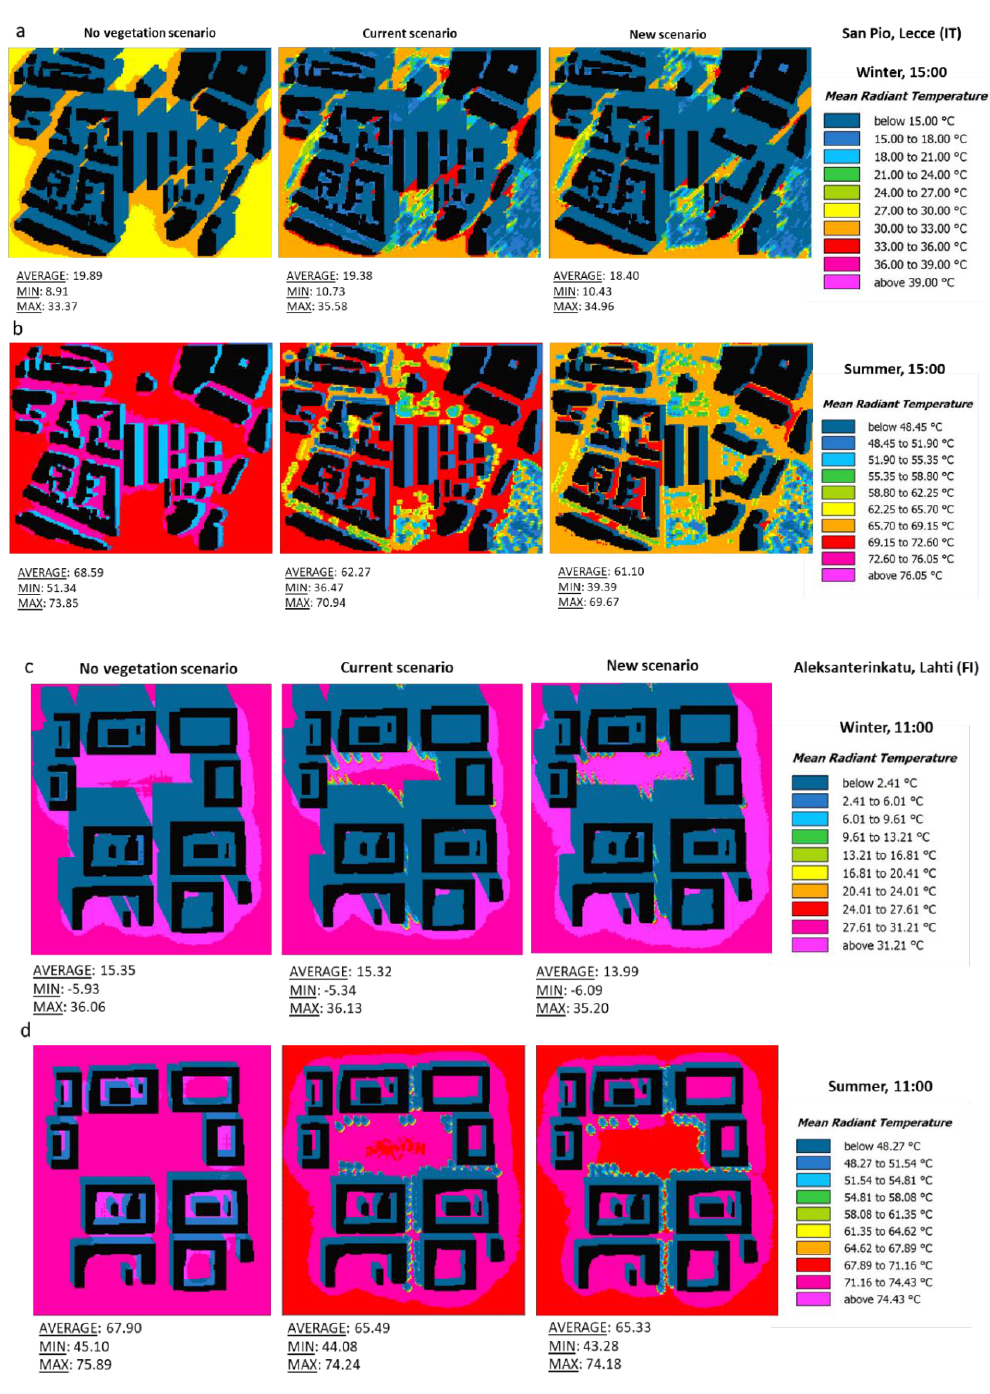
Figure 7. Spatial distribution of mean radiant temperature (MRT) at 15:00 in San Pio ( a , b ) and at 11:00 in Aleksanterinkatu ( c , d ) at height of 1.4 m for the no vegetation scenario (left), current scenario (middle) and new scenario (right) in winter and summer days.